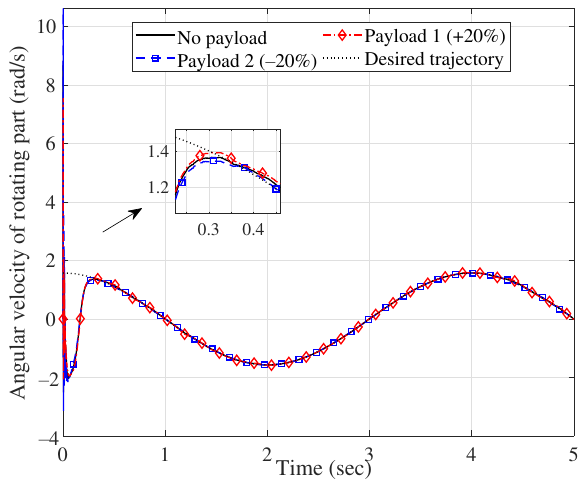
Figure 19. Angular velocity of rotating part (Group